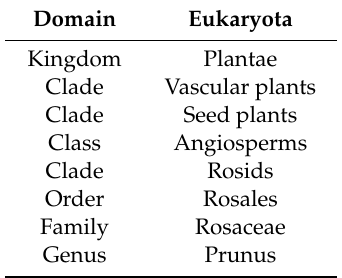
Table 1. Systematics of the species belonging to genus Prunus